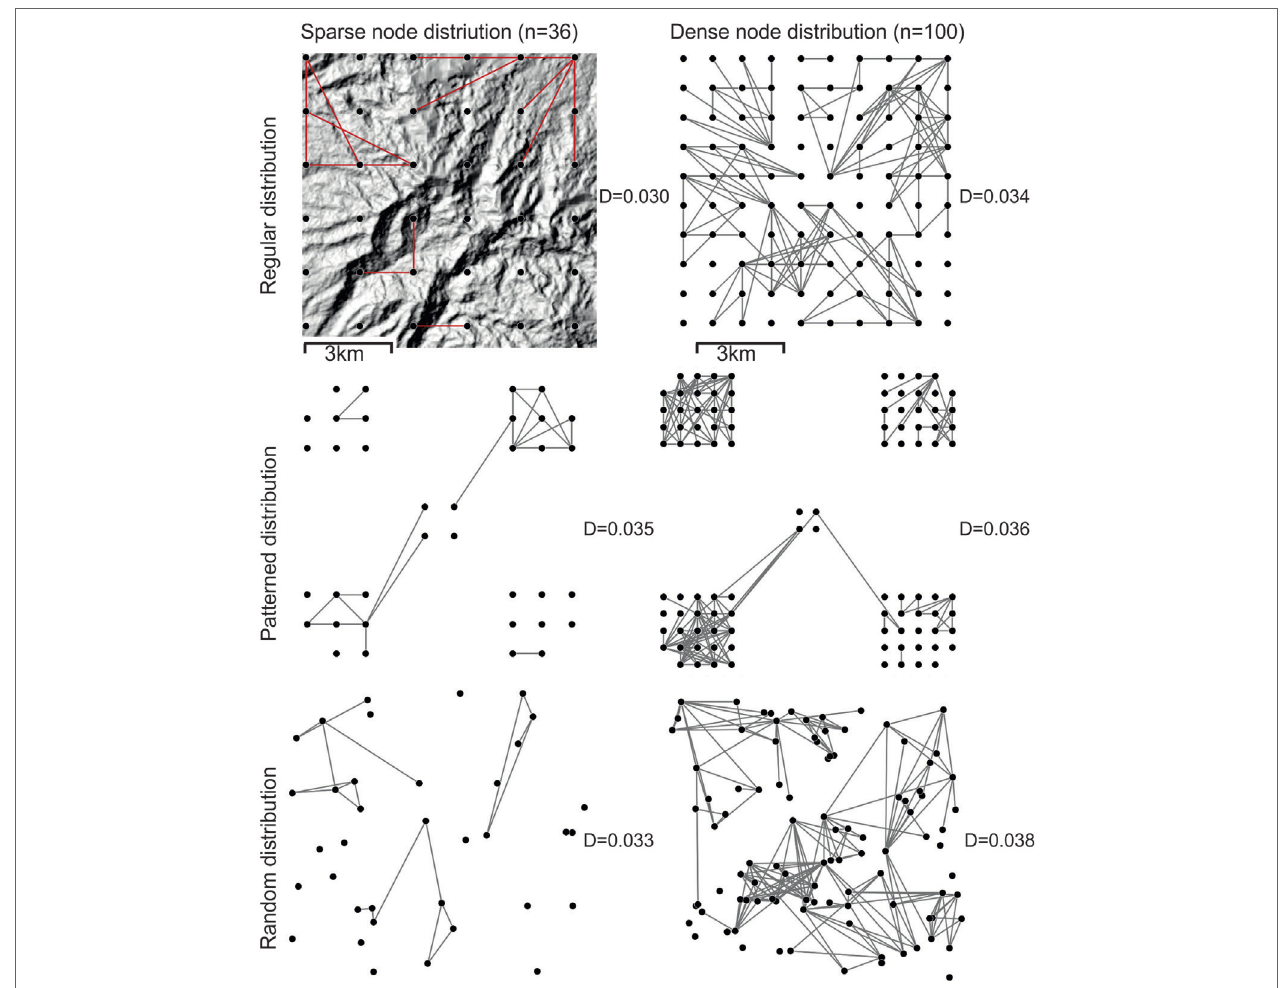
FigUre 10 | Densities (D) of visibility networks between differently distributed observation locations, with 10 m observer and target elevations, in a mountainous landscape (Basse-Terre in Guadeloupe, French West Indies) of 9 km by 9